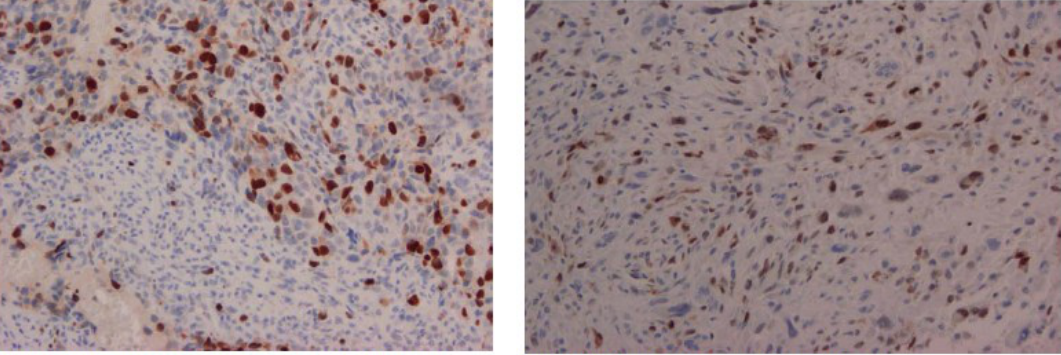
Figure 4. The immunohistochemical expression of topoisomerase IIα and ErbB2 proteins in pediatric osteosarcomas. ( A ) Heterogeneous topoisomerase IIα staining. ( B ) Diffuse topoisomerase IIα staining. ( C ) erbB2 protein